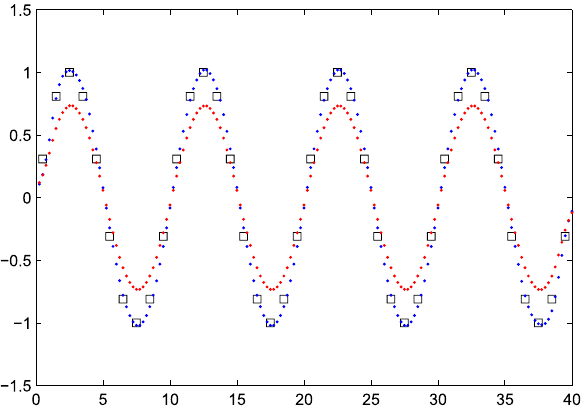
Figure 1. Deconvolution of a sine wave with fourfold super-resolution. The squares show the “observed” series. The blue and red dots represent the estimated ˆ x for κ = 0.01 and κ = 0.1 .